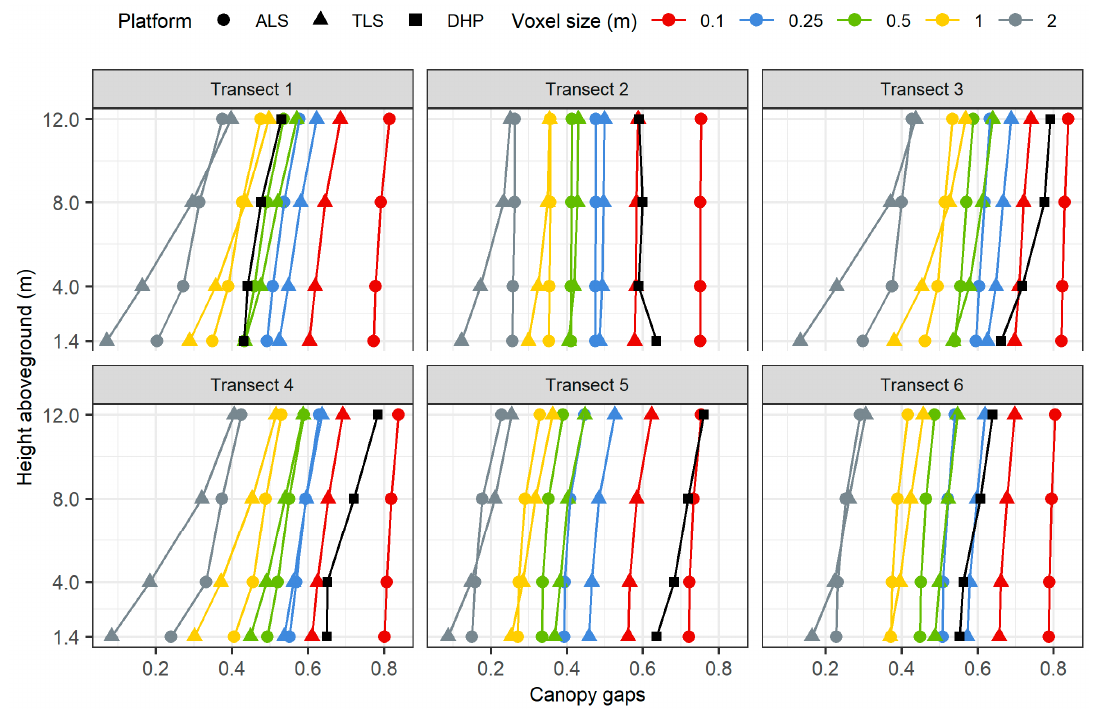
Figure 7. Canopy gap estimates derived from digital hemispherical photography (DHP), airborne laser scanning (ALS), and terrestrial laser scanning (TLS) along the six vertical transects.